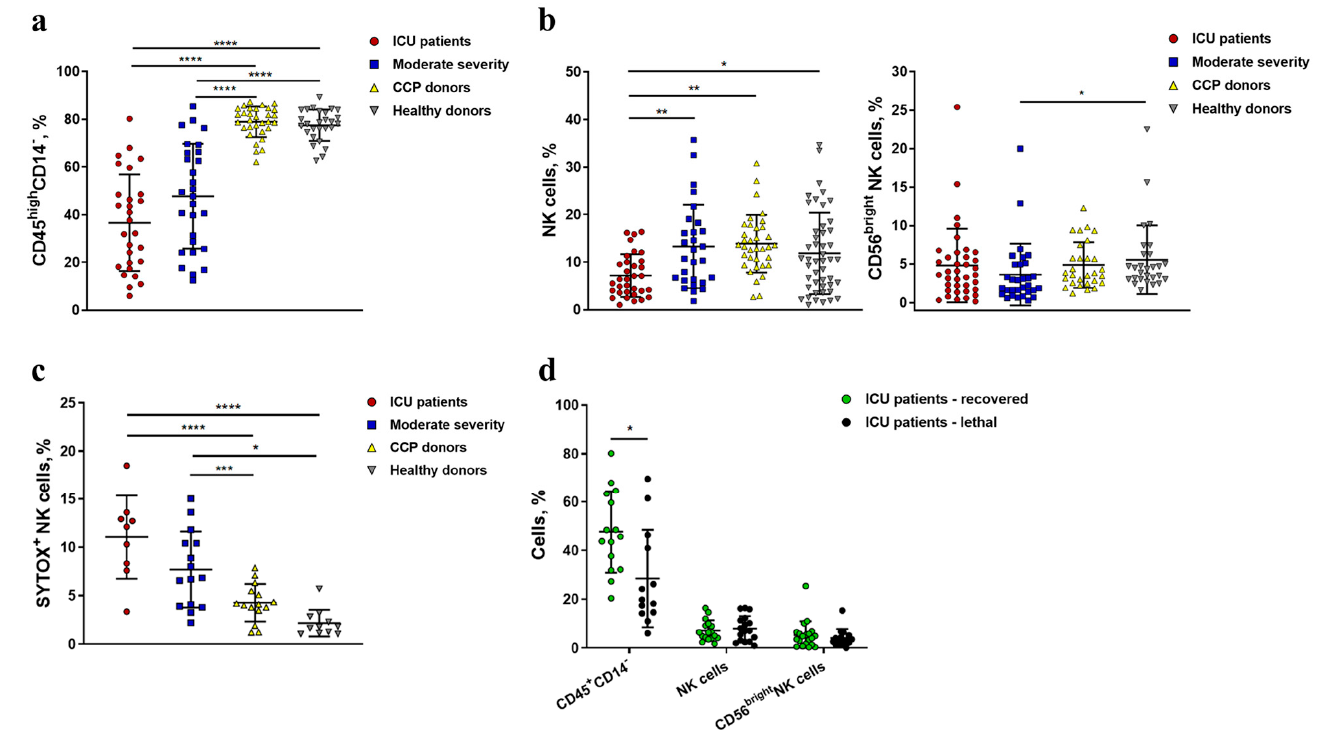
Figure 2. Peripheral blood levels and viability of lymphocytes from COVID-19 patients, convalescent patients, and healthy donors. ( a ) CD45 high CD14 − cell percentage in PBMC was assessed in the following groups: ICU patients (n = 28), moderate-severity patients (n = 28), CCP donors (n = 31), and healthy donors (n = 27). ( b ) NK cell percentage among CD45 high CD14 − cells and CD56 bright NK cell percentage among all NK cells in blood samples from ICU patients (n = 34), moderate-severity patients (n = 31), CCP donors (n = 31), and healthy donors (n = 48). ( c ) Percentage of dead cells measured in blood samples from ICU patients (n = 9), moderate-severity patients (n = 15), CCP donors (n = 15), and healthy donors (n = 15). ( d ) Comparative analysis of CD45 high CD14 − cell, NK cell, and CD56 bright NK cell levels in the recovered and lethal patients from the ICU group. Data are presented as individual values with mean ( ± SD). * p < 0.05, ** p < 0.01, *** p < 0.001, **** p < 0.0001.